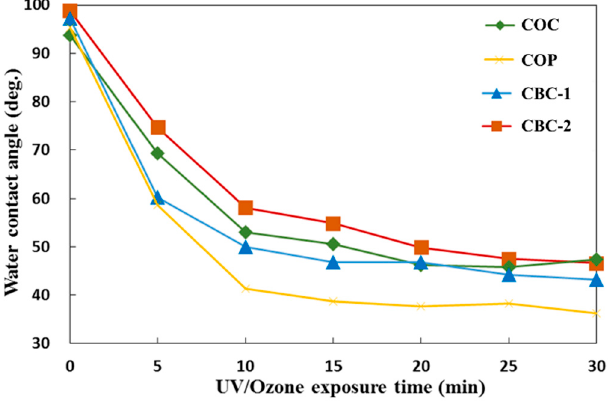
Figure 4. Water contact angle measurements for CBC-1, CBC-2, COC, and COP surfaces by ultraviolet (UV)/ozone exposure time. The contact angles values are the average of three individual measurements.